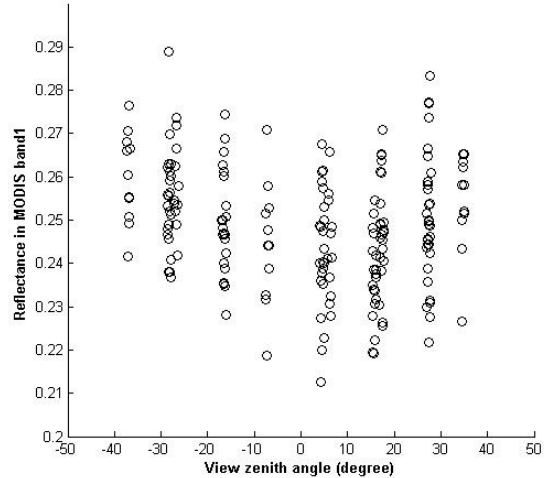
Figure 7. The calibration site’s directional characterization of the red band of Terra/MODIS. The reflectance varies with relative azimuth and solar zenith angles for each bin of the view zenith angle, which shows systematic variation, which is due to directional effects. The directional effect is about 15%.